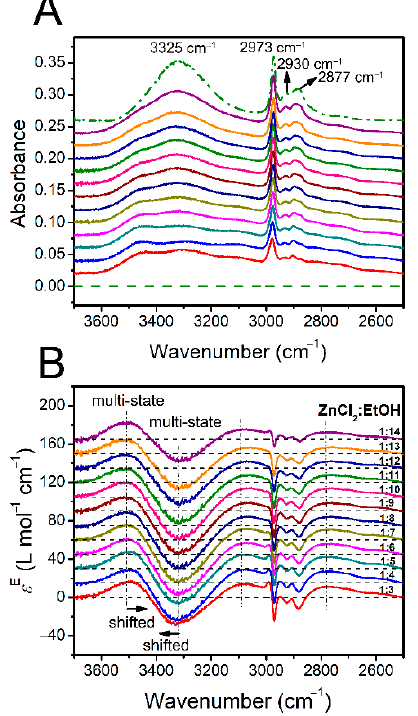
Figure 1. ATR-FTIR ( A ) and excess IR ( B ) spectra of ZnCl 2 -EtOH mixtures in ν (O − H) and ν (C − H) regions. The dash and dash-dotted spectra in ( A ) are pure ZnCl 2 and EtOH, respectively. The molar ratios of the two components are labeled in ( B ). For a better presentation, the baselines of spectra in ( A , B ) have been shifted.